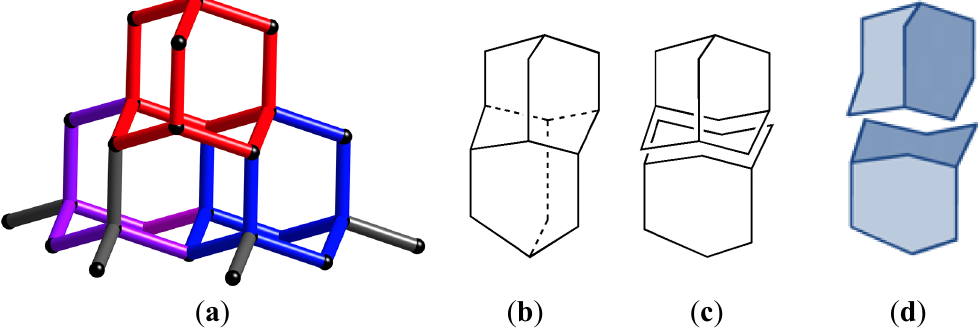
Figure 2. ( a ) Fragment of the diamond net ( dia ). Different tiles marked in red, purple and blue. ( b ) Framework of two tiles; ( c ) Framework of two tiles separated; ( d ) Two tiles